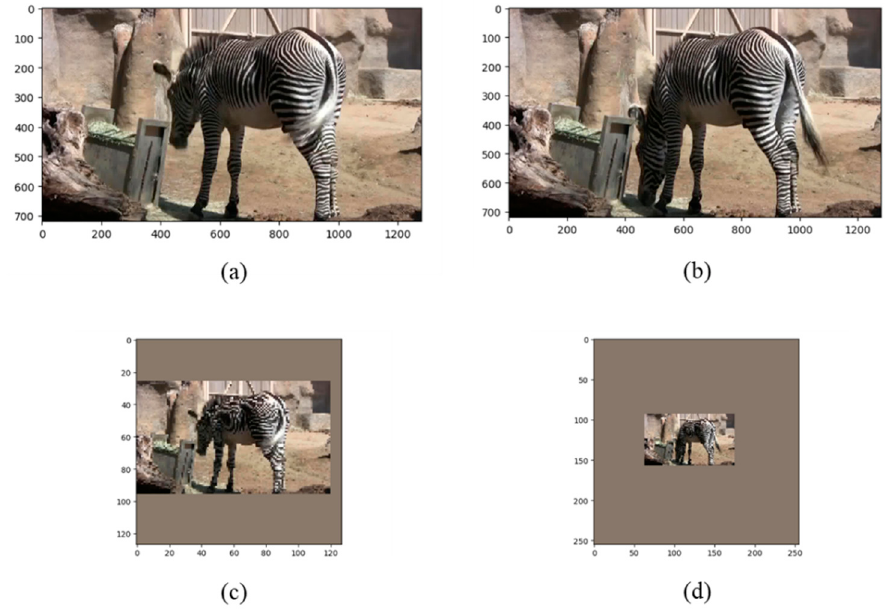
Figure 11. Preprocessed Training Dataset. ( a ) Original target image, ( b ) Original search region, ( c ) Converted target image, ( d ) Converted search